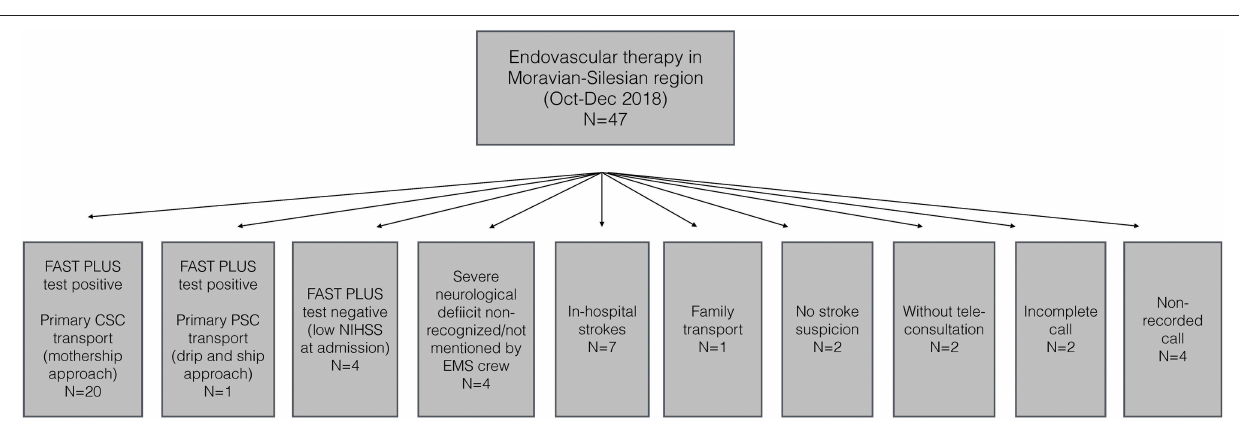
FIGURE 2 | Prehospital routes of EVT patients in the Moravian-Silesian region (October–December